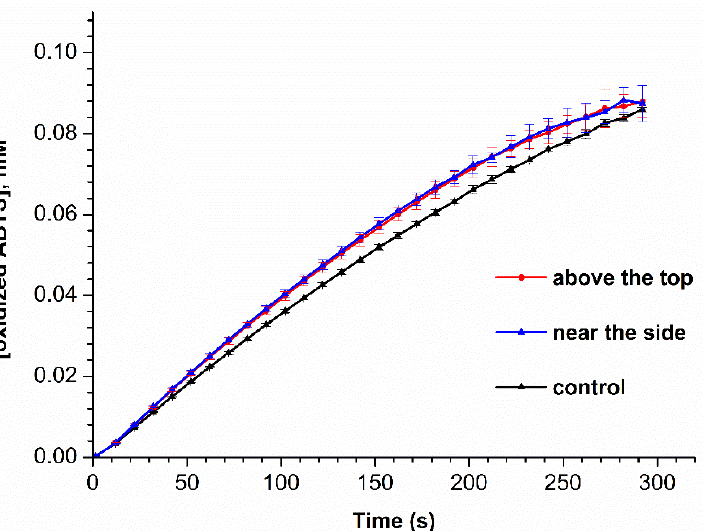
Figure 5. Time dependencies of concentration of oxidized ABTS in the HRP-ABTS-H 2 O 2 system for HRP samples incubated either 2 cm above the conical coil (red), to the side of the coil (blue), or 50 m away from the coil (black, control experiment). Measurement conditions: HRP:ABTS:H 2 O 2 = 1 nM:2.5 mM:0.3 mM; pH 5.0; solution absorbance was monitored at 405 nm wavelength; cell pathlength was 1 cm, solution temperature was 25 °C.